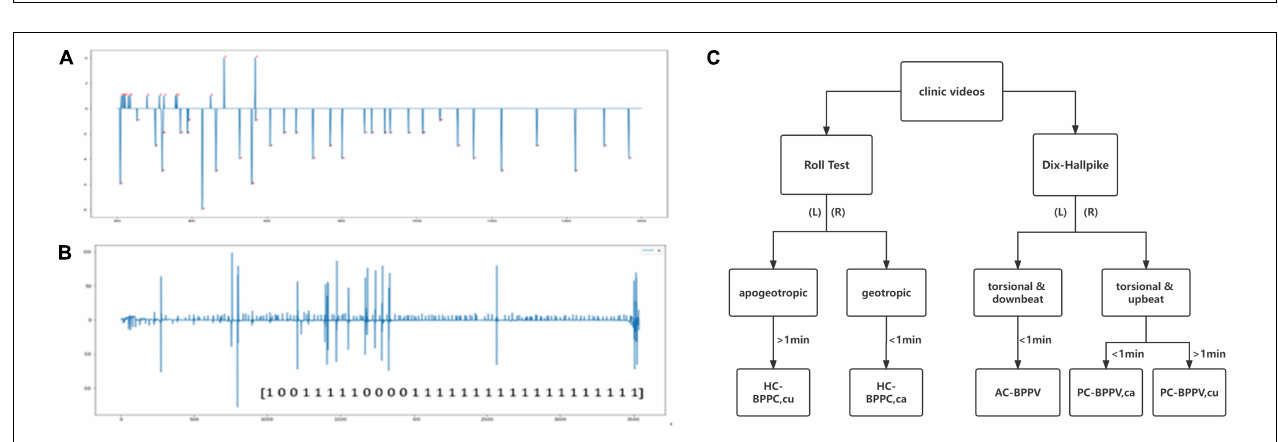
FIGURE 6 | Disease diagnosis process. (A) Peak detection: all velocity peaks in two directions are detected. (B) The predicted labels of test data, longest consecutive positive sub-samples represent the position of nystagmus. (C) The decision tree that simulates the diagnosis of specialists.